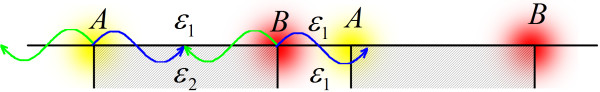
Corners of grating will become the scatting points of the incident light which was the source of GSPs. These scatting points can be divided into two kinds due to the geometric symmetry, which is A and B. Each scatting point will scatter into two GSP modes propagating in two directions (blue and green).